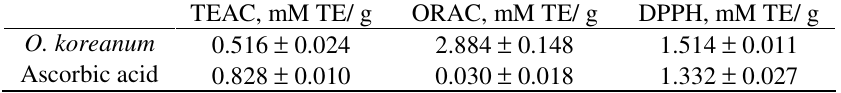
Table 1. The antioxidant activities of ethyl acetate fraction of O. koreanum.